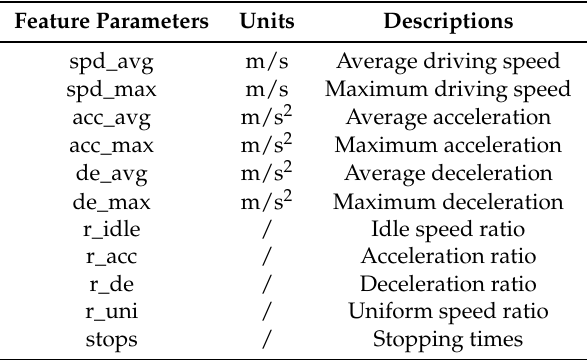
Table 2. BPNN inputs: 11 feature parameters.